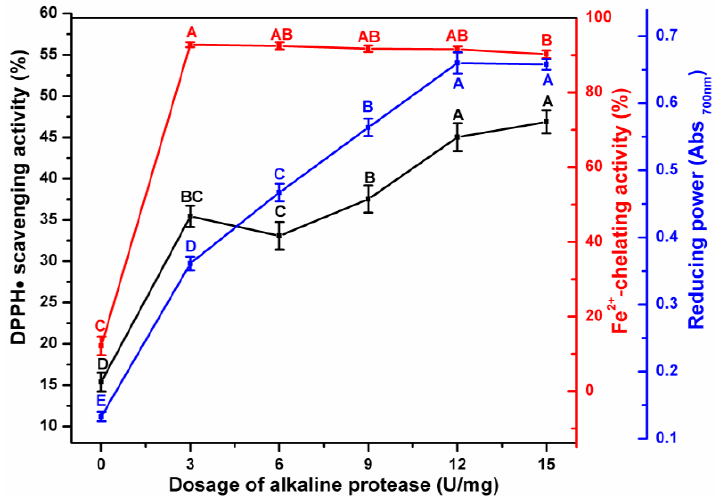
Figure 2. Effect of alkaline protease dosage on antioxidant activity of ESM-EH with the assistance of 30 mM Na 2 SO 3 . DPPH•-scavenging activity (black line); Fe 2+ - chelating ability (red line); reducing power (blue line). The different capital letters indicate significant differences ( p < 0.05).